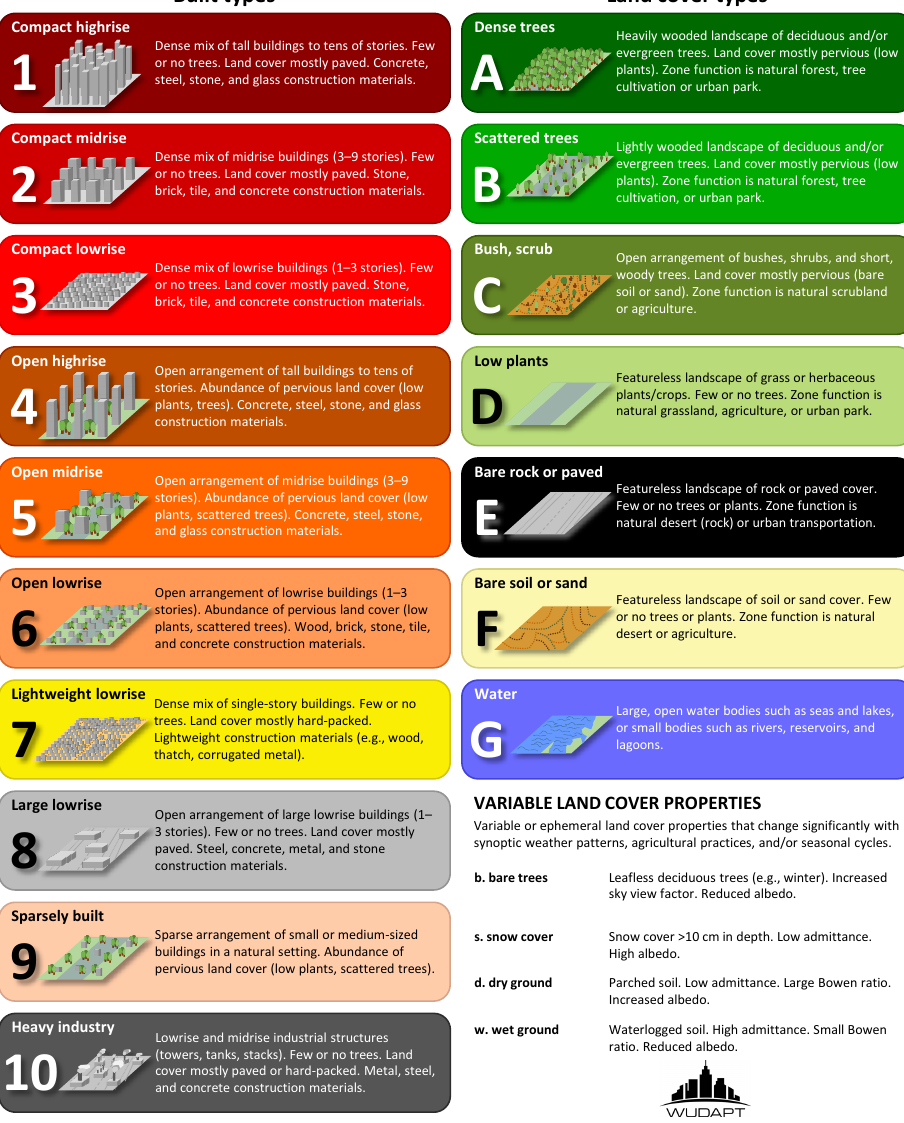
Figure 1. Urban (1–10) and natural (A–G) Local Climate Zone definition